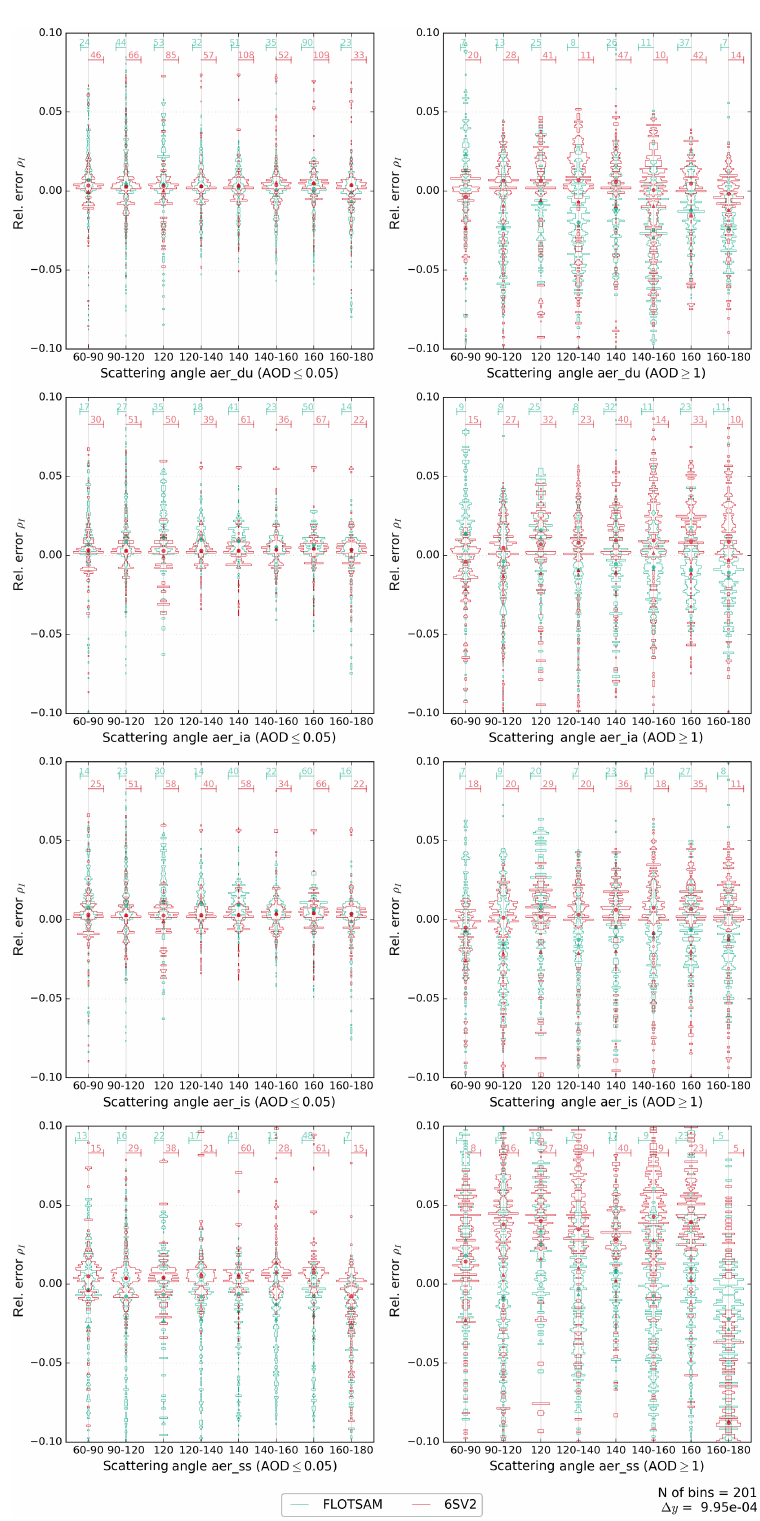
Figure A3. Histograms for the relative error of the FLOTSAM and 6SV2 models. Similar to Fig. 4 but only for AOD ≤ 0 . 05 in the left column and AOD ≥ 1 in the right column (AOD at 550nm). Relative error histograms are presented as a function of the scattering angle. The scattering angle has been binned at intervals with similar quantities of data points. The four aerosol types considered in this work are shown in different